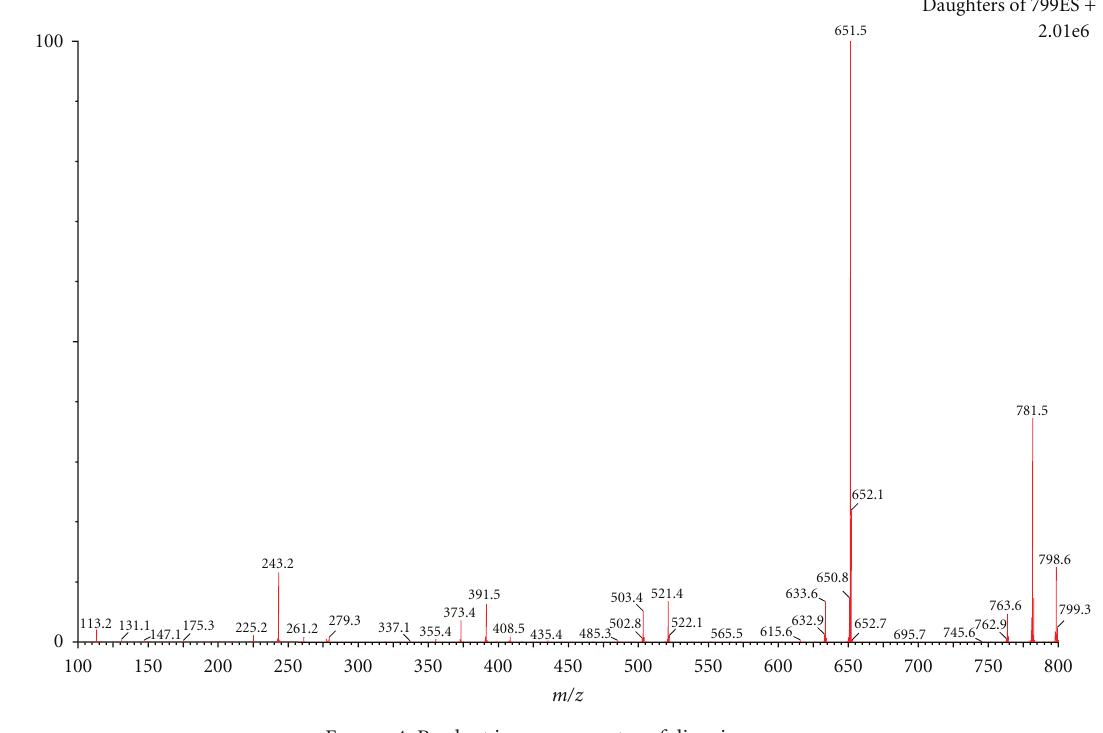
Figure 4: Product ion mass spectra of digoxin.